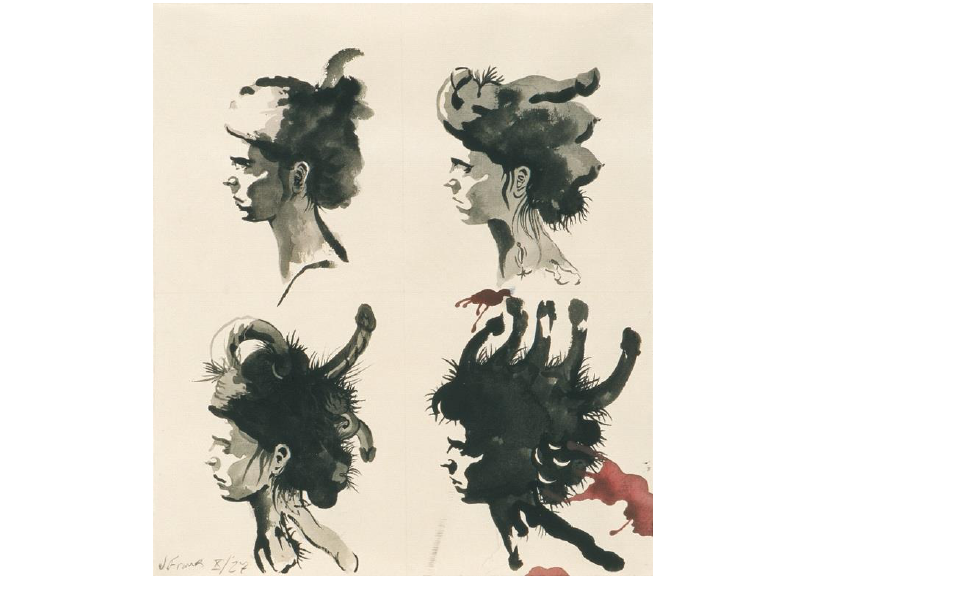
Figure 19. Justine Frank, from “The Stained Portfolio” , 1927 – 1928, gouache on paper, 33 × 38 cm. Courtesy of the artist.